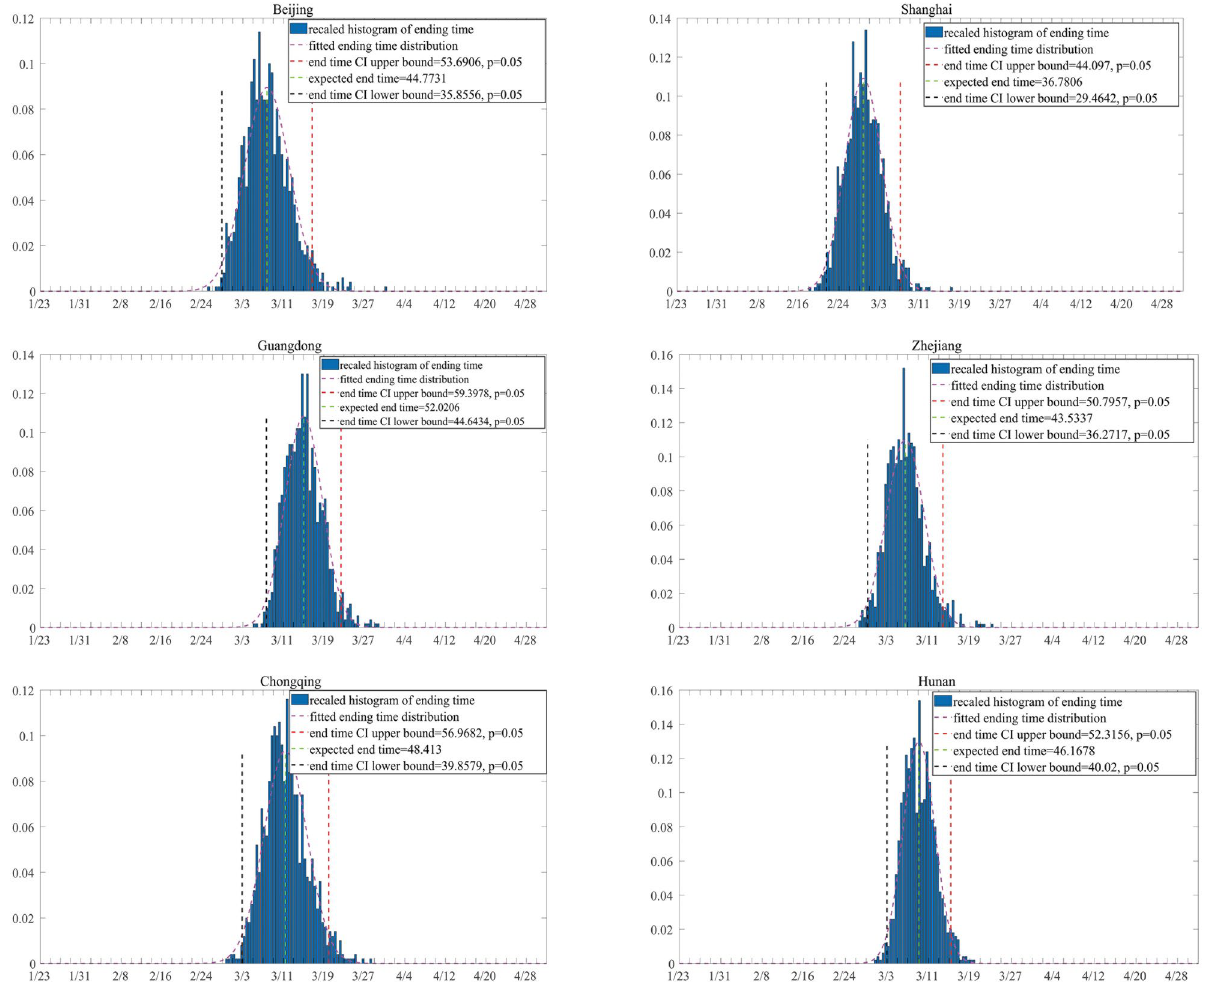
Figure 3. Prediction of the containment time of the outbreak. The containment time of 1000 simulations is plotted as a histogram and is fitted with normal distribution for each region. The y axis represents the density of containment